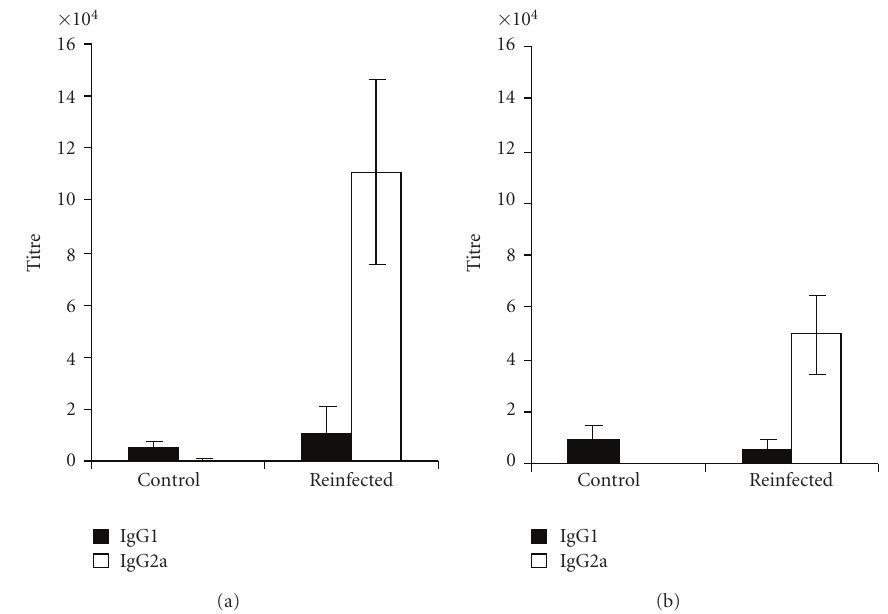
Figure 4: Analysis of the humoral responses. Serum samples from control and vaccinated reinfected mice were obtained seven weeks after challenge in the ear dermis. The titre for IgG1 and IgG2a antibodies against LRP (a) and SLA (b) was determined individually by ELISA. Results are expressed as the mean ± SD. Table 1: Cytokine production by popliteal DLN cells from vaccinated reinfected mice at week seven after secondary challenge. SLA LRP Medium IFN- γ 5837 . 16 ± 834 . 82 5773 . 52 ± 1411,14 IL-10 526 . 31 ± 214 .